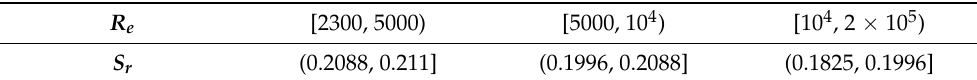
Table 4. Interval values of the Strouhal number S r depending on the intervals of Reynolds number R e for labial pipes.